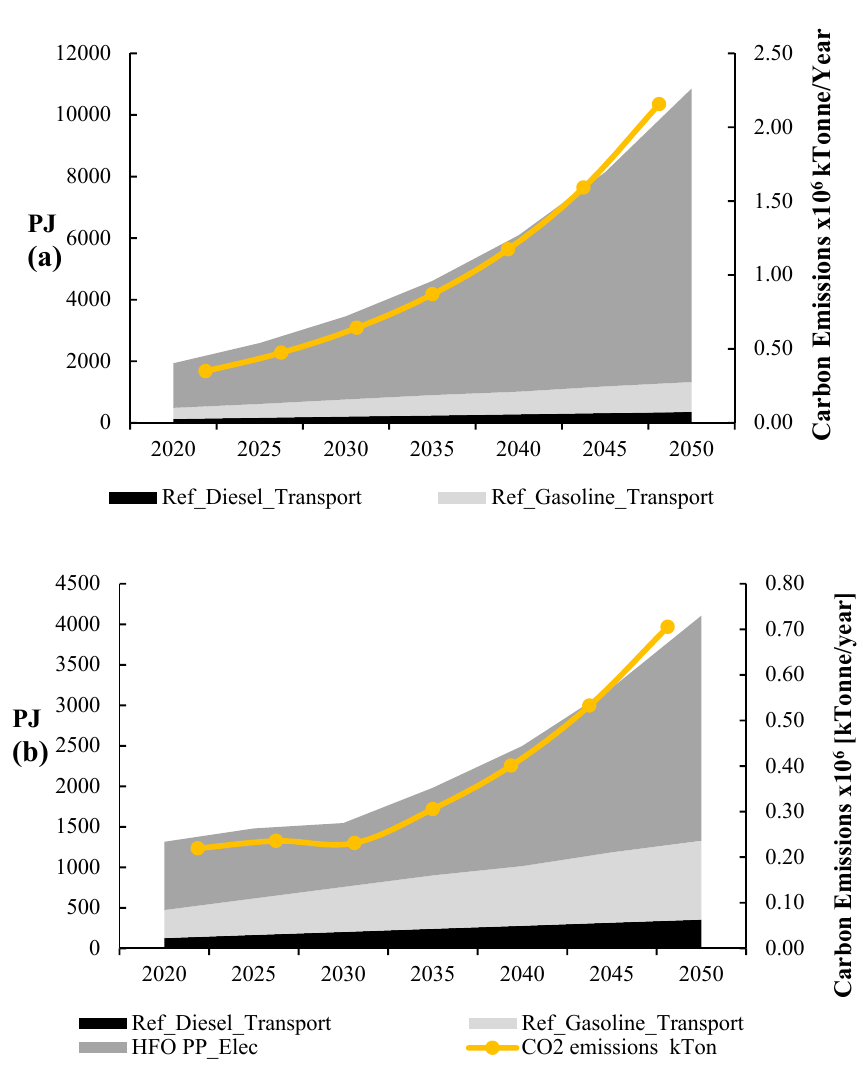
Figure 2. Energy/technology Mix under ( a ) BAU case ( b ) BAU case with 60% energy efficiency targets. Figure 2. Energy / technology Mix under ( a ) BAU case ( b ) BAU case with 60% energy e ffi ciency